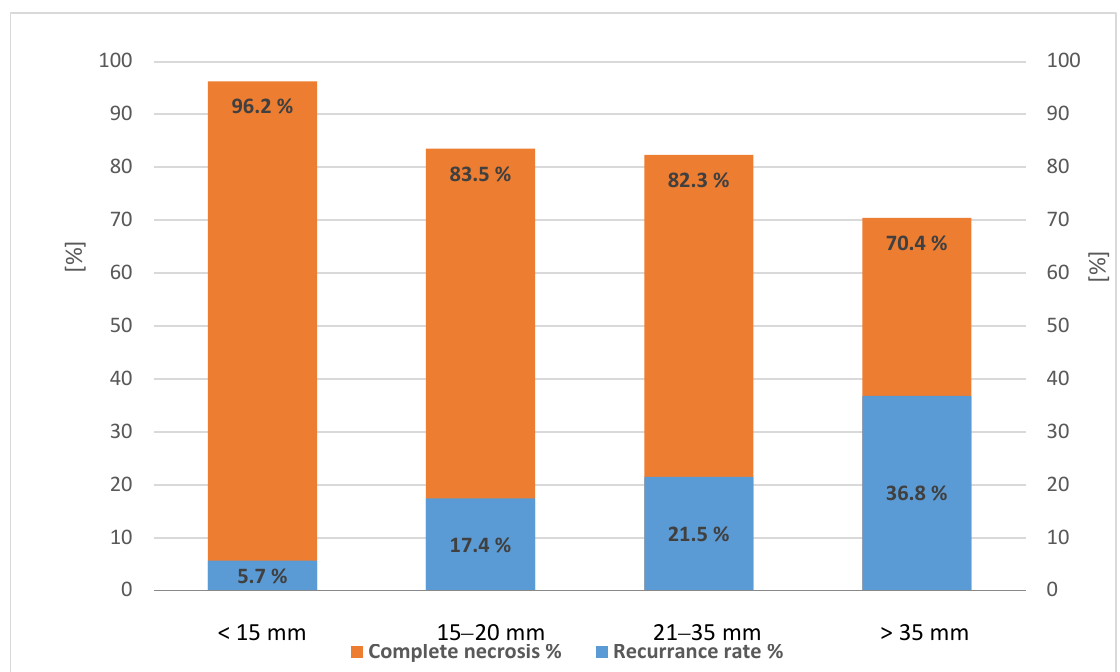
Figure 1. Rate of complete necrosis (left axis) and recurrence rate (right axis) in 331 hepatocellular carcinoma (HCC) nodules treated with any percutaneous thermal ablation, p < 0.05 (test for trend).